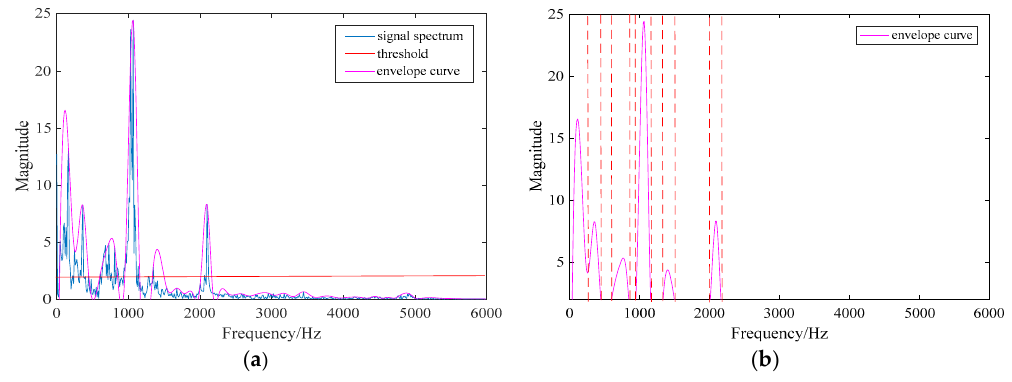
Figure 3. Trimming process of the signal spectrum: ( a ) frequency spectrum and envelope curve; ( b ) trimmed envelope curve.